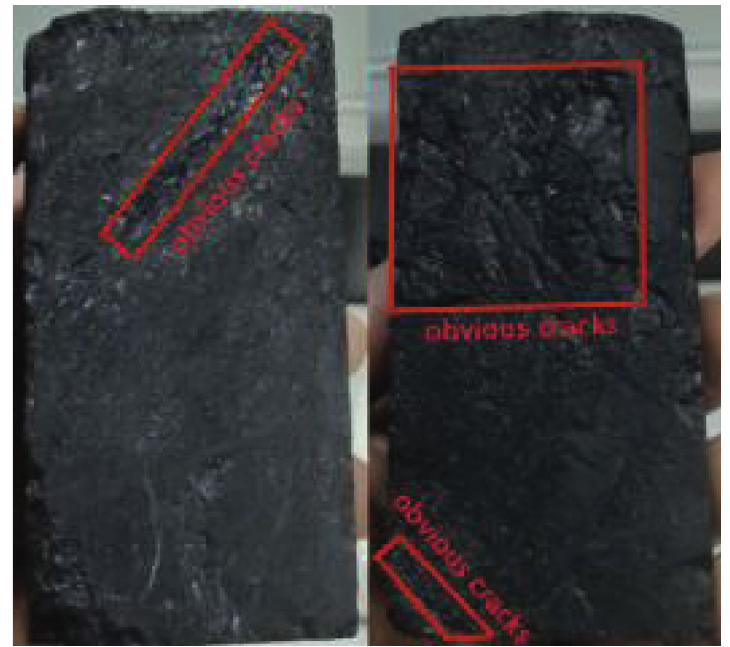
Figure 5: Elimination of coal sample in mechanical